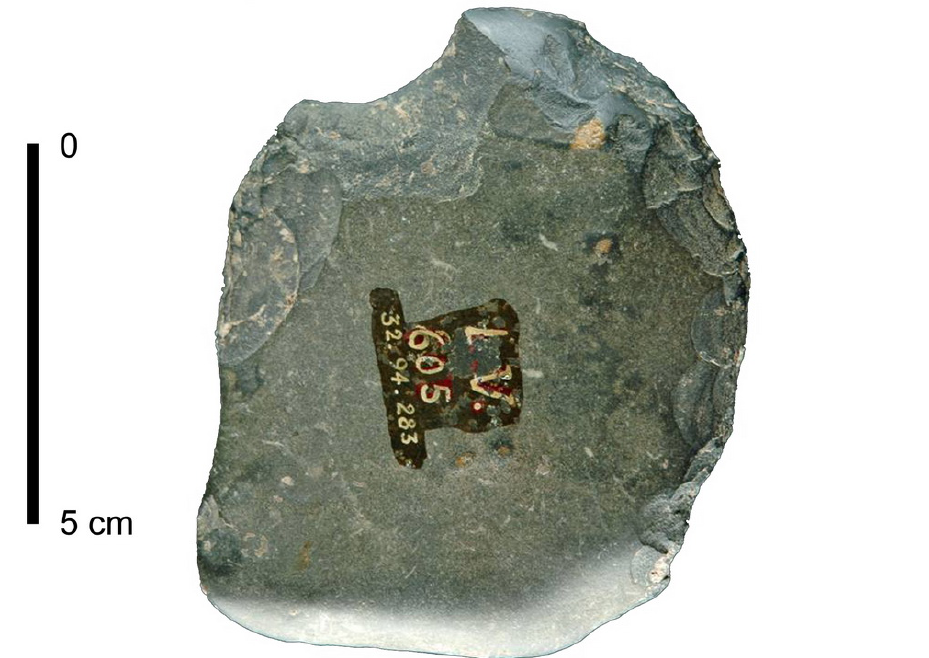
Figure 19. L’outil hoabinhien vu sous l’angle d’un outil de survie. (H. Forestier). Figure 19. Hoabinhian tool view under the angle of a multipurpose survival tool concept. (H. Forestier). 9. Vers l’ouverture d’un nouveau face-à-face : la pierre et son